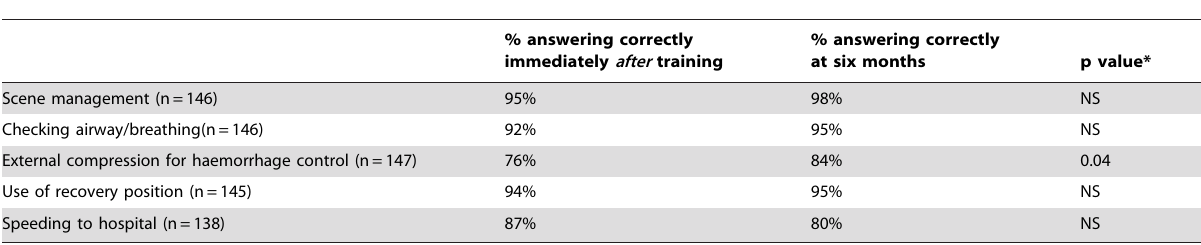
Table 4. Participants’ fund of knowledge at six months compared to after initial